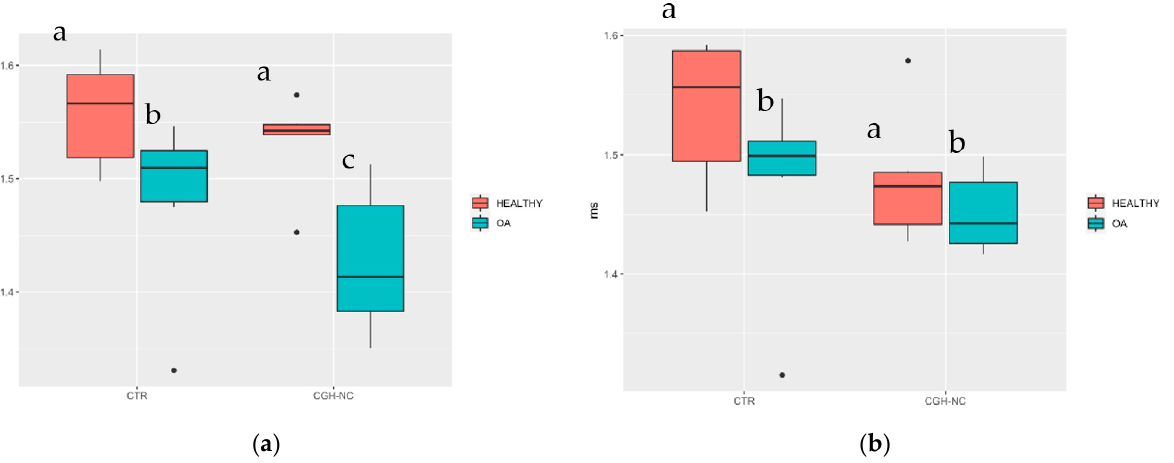
Figure 11. Whiskers plots box for “D2D Femoral Lateral” ( a ) and “D2D Tibial Lateral” ( b ) showing significant OA changes regardless of the treatment group. Equally, in the “D2D Femoral Lateral” variable, differences could be seen in the OA stifles between treatments. Groups with different letters refer to a statistical significance.